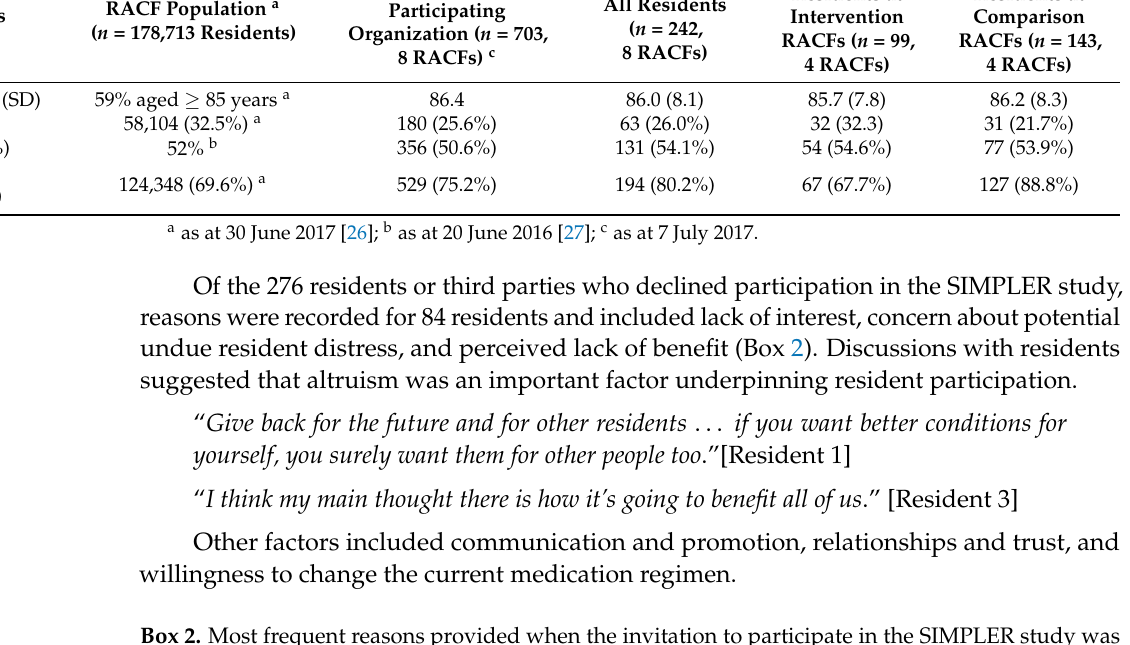
Table 1. Characteristics of the Australian residential aged care population, all permanent residents of RACFs operated by the aged care provider organization, and residents participating in the SIMPLER study.